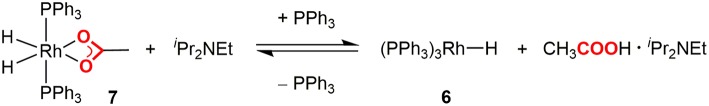
Equilibrium between the Rh(III) dihydride and Rh(I) monohydride complexes.